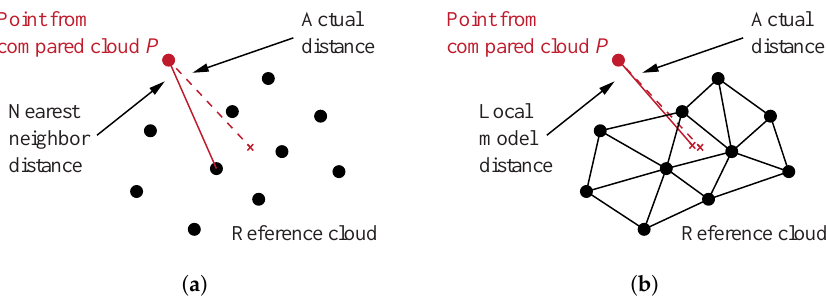
Figure 10. Cloud-to-cloud distances computation using: ( a ) the nearest neighbour distance; ( b ) methods in which a local model is applied between the nearest point and a definite number of neighbouring